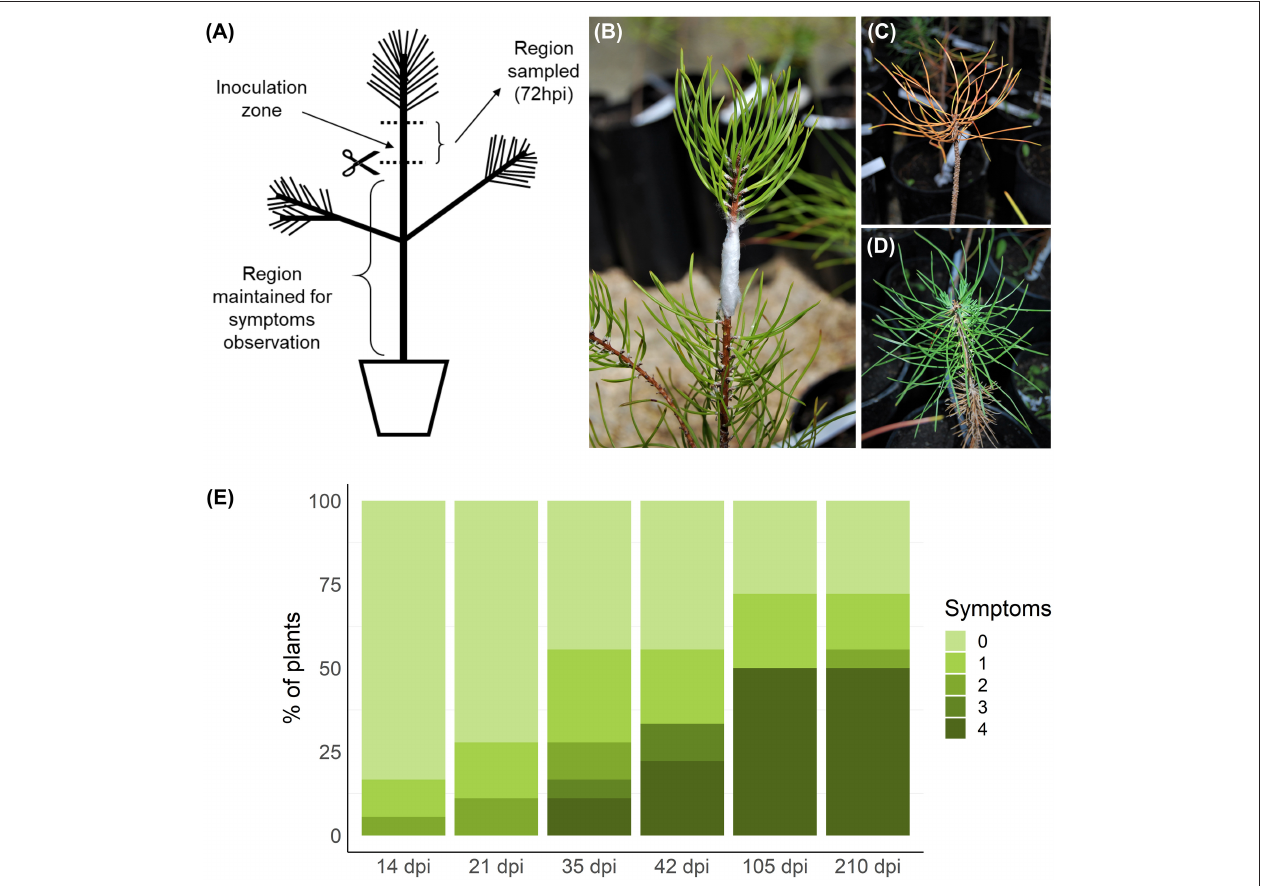
FIGURE 1 | Inoculation, sampling, and symptoms observation. Plants were inoculated in the stem, below the apical region (A,B) . Samples of the stem, including the inoculation zone, were collected 72h post-inoculation (hpi). After debarking, these samples were homogenized and total RNA was extracted. The remaining part of the plant, below the cutting region, was maintained for symptoms observations for 210 days post-inoculation (dpi). Symptoms were evaluated weekly and registered according to a five-level scale based on percentage of brown/wilted needles: 0, 0% (D) ; 1, 1–25%; 2, 26–50%; 3, 51–75%; 4, 76–100% (C) . Symptom progression in selected timepoints is represented in (E) . Plants without any visible symptom at the end of the experiment were considered